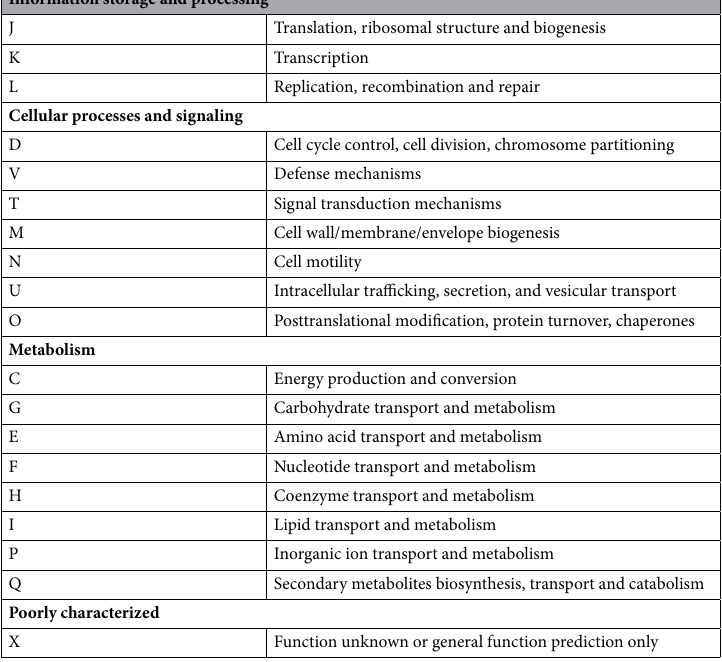
Table 2. Protein functional classes, partitioned into higher